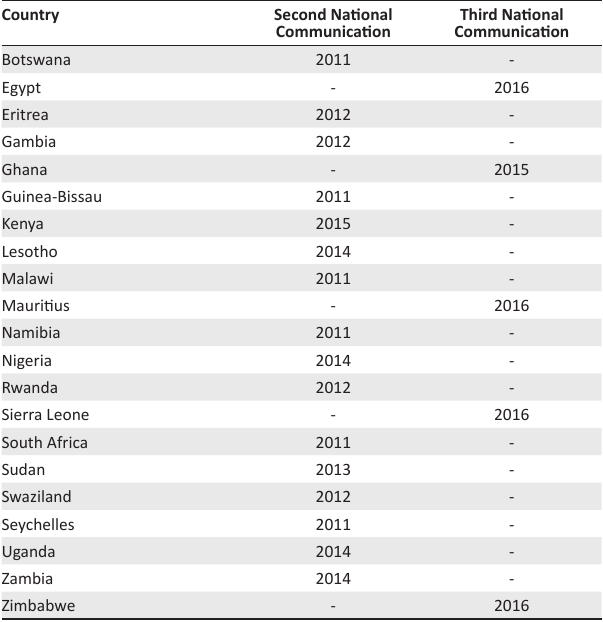
TABLE 1: Sampled countries and National Communications